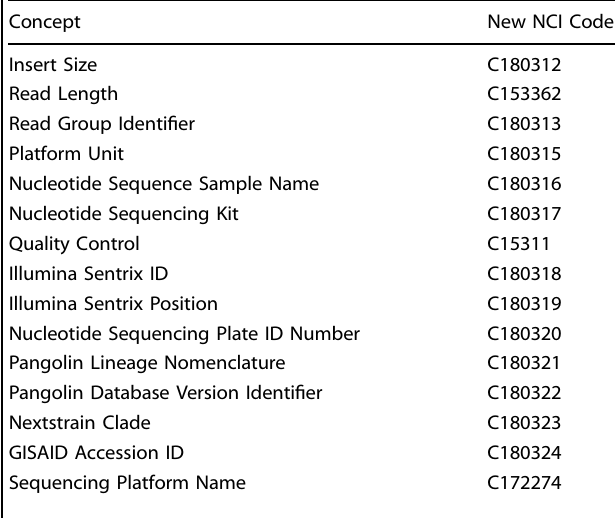
Table 7. Details of the 15 concepts that were submitted to NCI to request creation of codes and the newly created